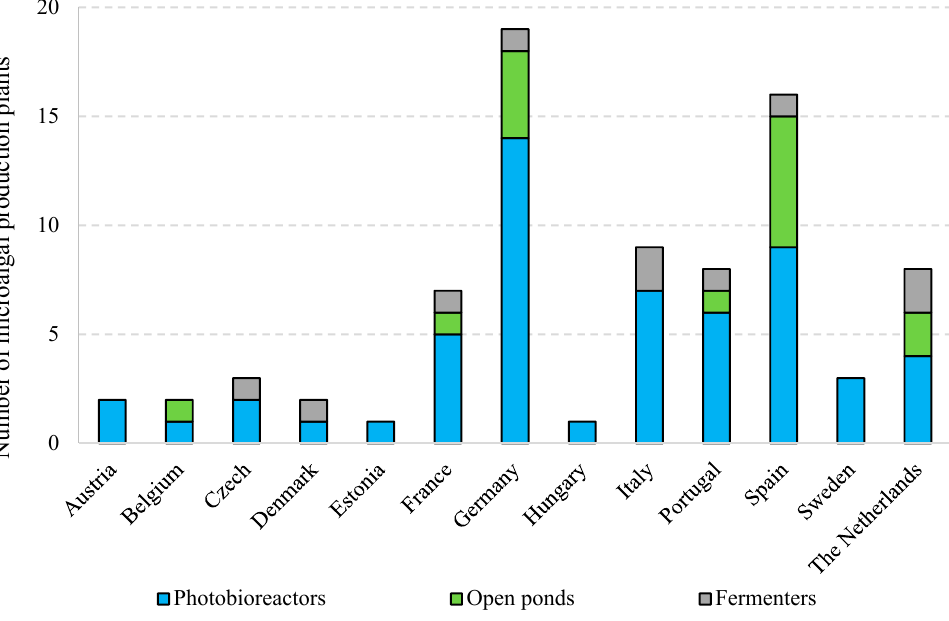
Figure 7. Number of microalgal production plants in the EU in 2021 [58].